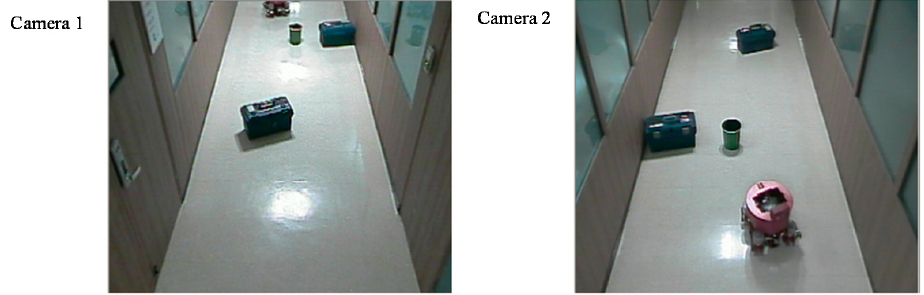
Figure 18. Objects in the experimental environment.